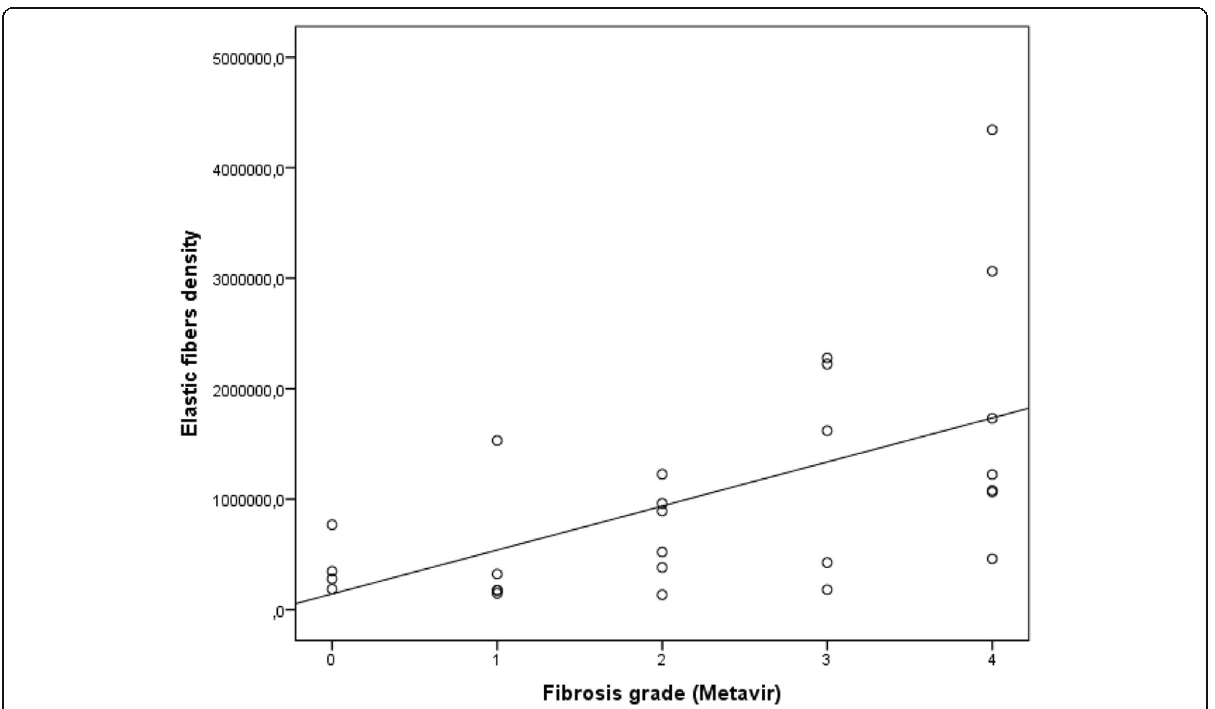
Fig. 4 Correlation of stage fibrosis and elastic fibers density, Spearman test, r = 0.609, p <